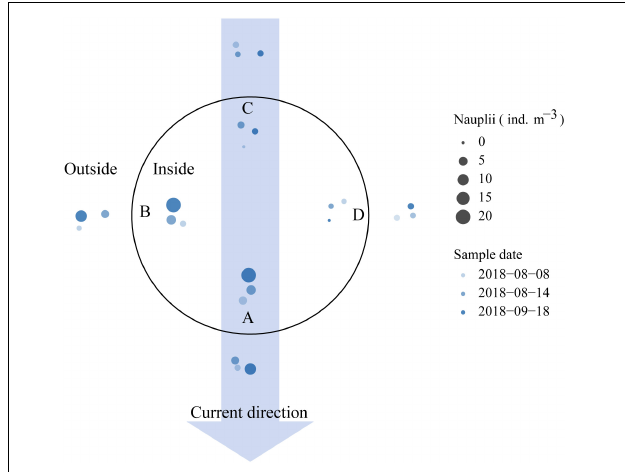
FIGURE 6 | Comparison of sea lice densities obtained at different sampling points. Arrow indicates surface current. Circles indicate where samples were taken inside and outside of the sea cage (blue circles) at sample points A to D on three sample days (variable colors). Size of colored circles indicates planktonic lice per m − 3 found at each sample point and time (scale shown by black circles in legend).